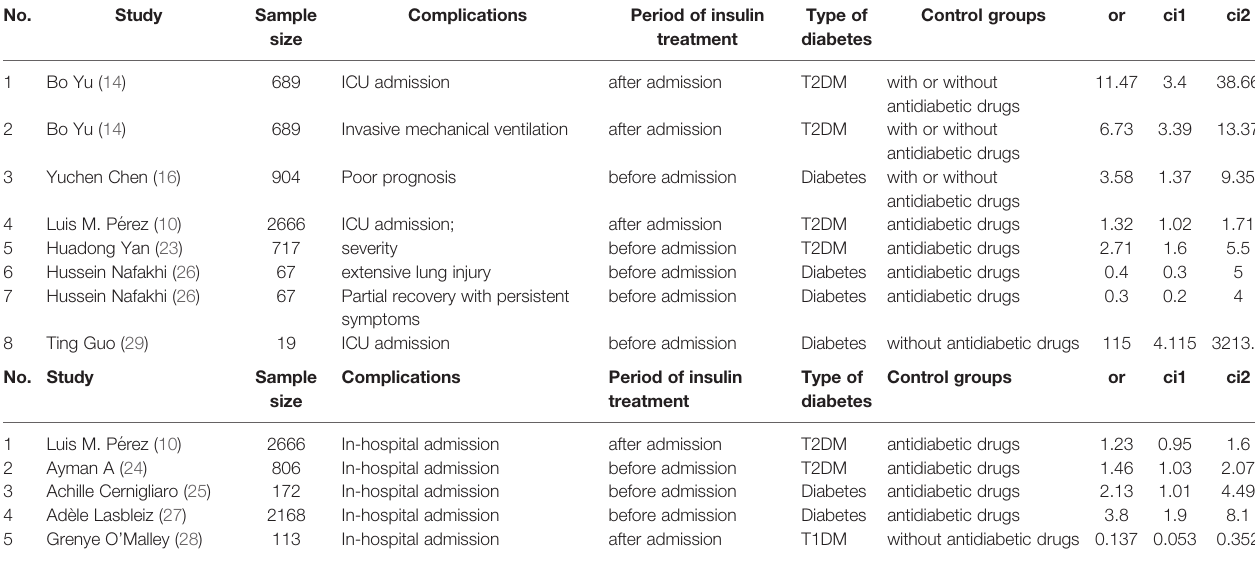
TABLE 3 | Description of studies reporting the association between insulin treatment and the severe/critical complications or in-hospital admission of COVID-19.